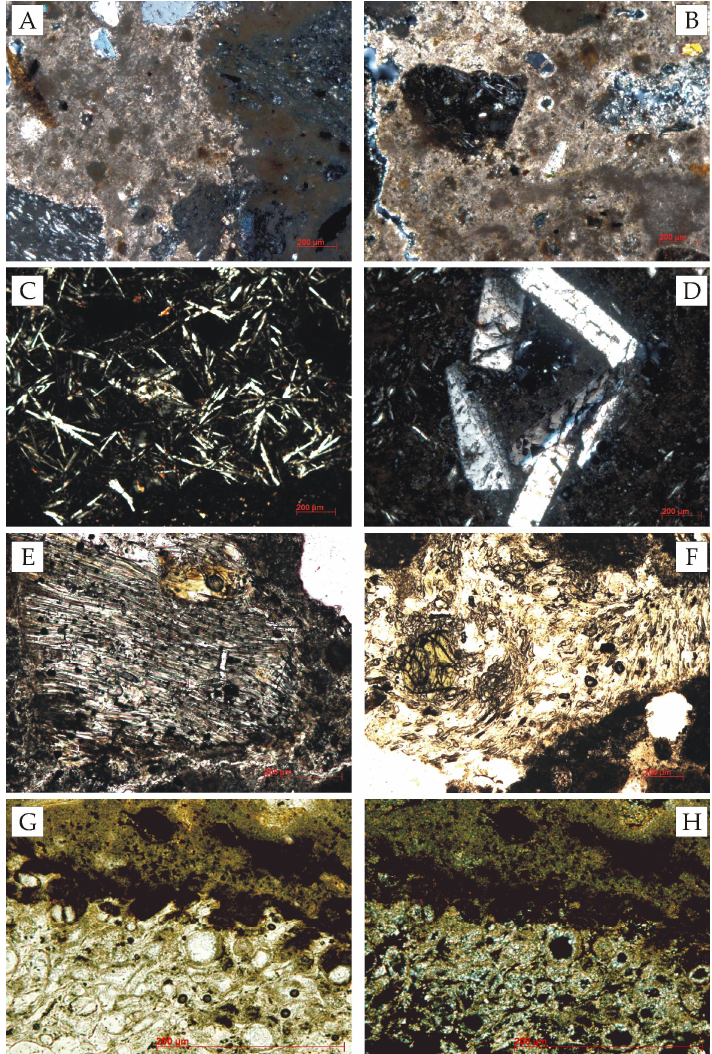
Figure 4. Some of the representative mortars: ( A,B ) cryptocrystalline and recrystallized aspect of the binder and aggregate constituted by trachytic rock fragments and glassy scoriae; ( C ) minute tabular crystals of sanidine in a trachytic fragment; ( D ) detail of tabular crystals of sanidine; ( E,F ) glassy scoriae and pumice fragments constituting the aggregate (clinopyroxene crystals are also evident); ( G,H ) non-birefringent portions of the binder at the interfaces with pumices fragment. Table 2. Mineralogical and textural features of mortar samples.